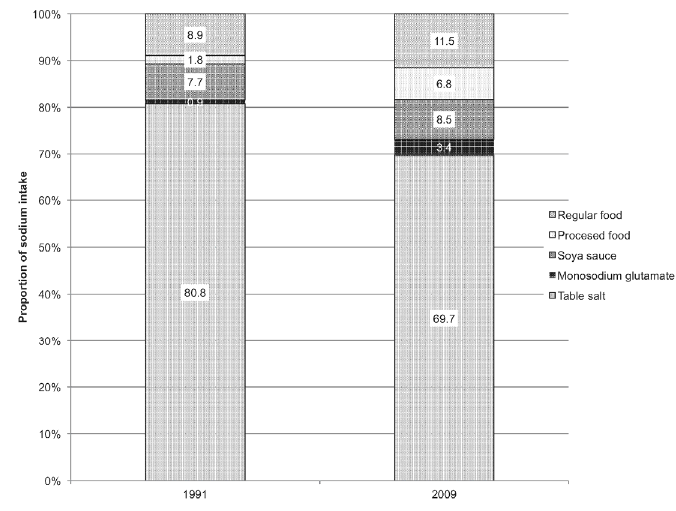
Figure 1. Sources of dietary sodium in China, 1991–2009 [58].